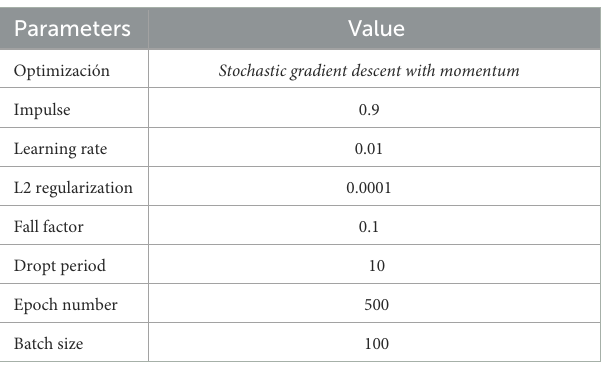
TABLE 1 Table with the parameters of the NN1 and NN2 network. TABLE 2 Table with the training parameters of the NN1 and NN2